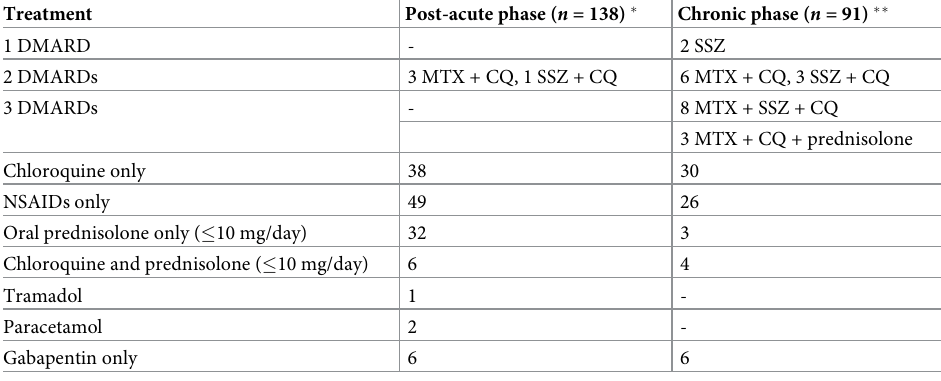
and presented as carpal tunnel syndrome in 3.6%. Two-thirds (32/48) of patients with neuro- pathic pain reported a greater than 50% improvement after taking 300 mg of gabapentin per day. Physical function and quality of life at illness onset were moderately impaired, with a mean (SD) Thai-HAQ score of 2.01 (0.84) and a mean (SD) value for the Thai version of the The treatments administered to patients in the post-acute and chronic phases are shown in Table 5. The treatments for the post-acute phase of CHIKV infection with which the patients showed a greater than 50% improvement in pain score at one-month follow-up included NSAIDs only (90%; 44/49), low-dose (10 mg or less per day) prednisolone (84.4%; 27/32), chloroquine (71.1%; 27/38), and conventional synthetic Disease-Modifying Anti-Rheumatic Table 5. Treatment for rheumatic involvement in patients in the post-acute and chronic phases of Chikungunya infection. Treatment Post-acute phase ( n = 138) � Chronic phase ( n = 91)